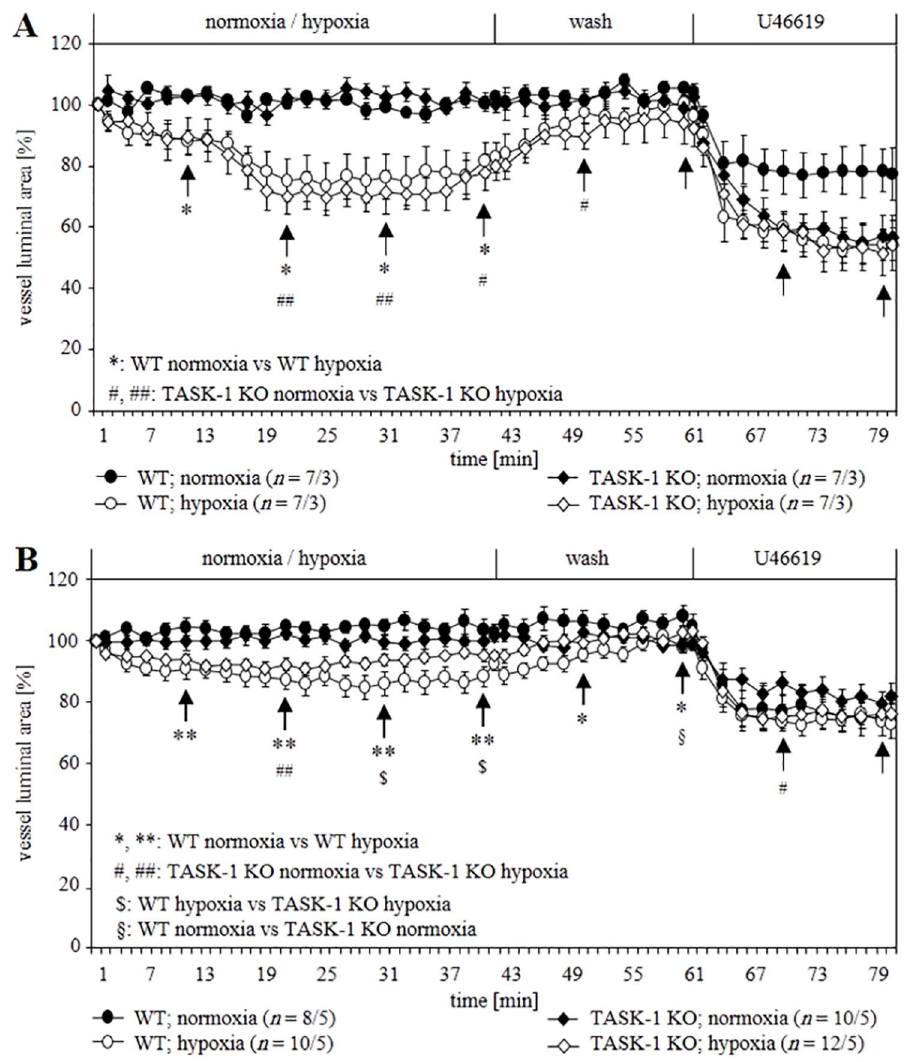
Fig 4. Videomorphometric analysis of the hypoxic response of intra- (A) and pre-acinar (B) arteriesof WT and TASK-1 KO mice. The luminalarea of vessels before exposure to hypoxia was set as 100%, and changesin the luminalareas are presentedas relative values. Hypoxia-induced constrictionof intra-acinar arteries was comparable in both mouse strains, whereasin KO pre-acinararteries, it started to fade earlieras comparedto WT. Data are presentedas mean ± SEM. n is numberof vessels/number of animals. Tests of significancewere done at the time points indicatedby arrows. * , #, §, $ P (cid:20) 0.05 and ** , ## P (cid:20) 0.01 (Mann– Whitney